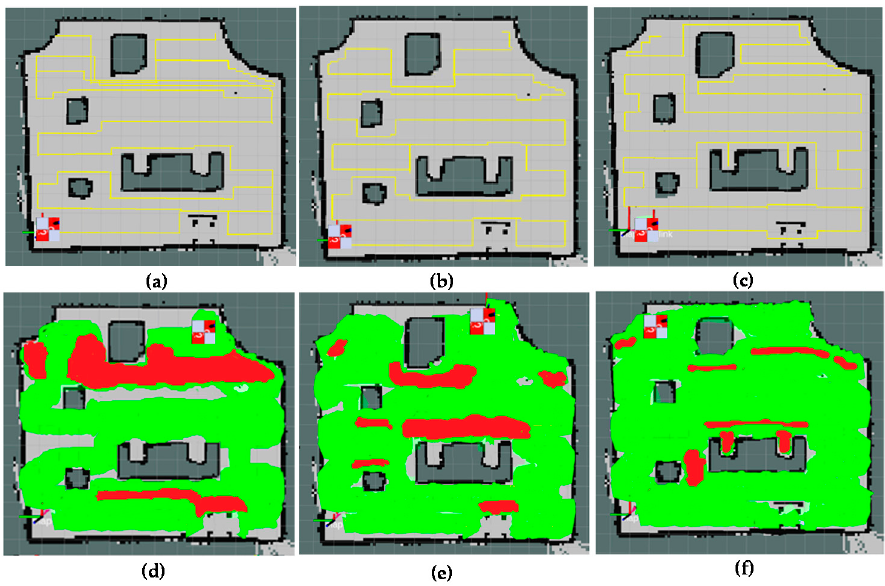
Figure 22. The area coverage comparisons. ( a , d ) path planning and covered areas of conventional A-star, ( b , e ) path planning and covered areas method [29], ( c , f ) path planning and covered areas of the proposed method with global path and shape planning. Table 1. The covered area ratio comparisons (%).